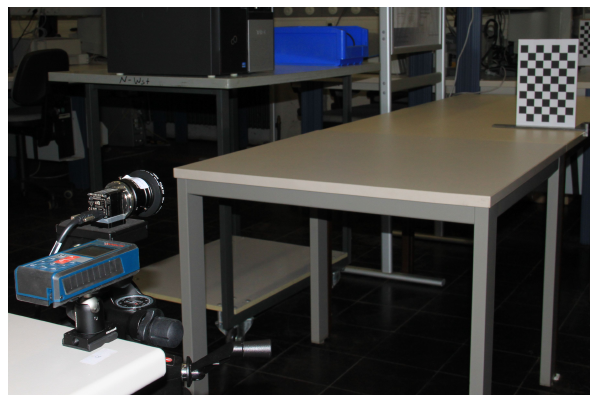
Figure 4. Setup to measure depth accuracy. A chessboard target in a defined distance is recorded by the Raytrix camera. A laser range finder measures the distance to the target for